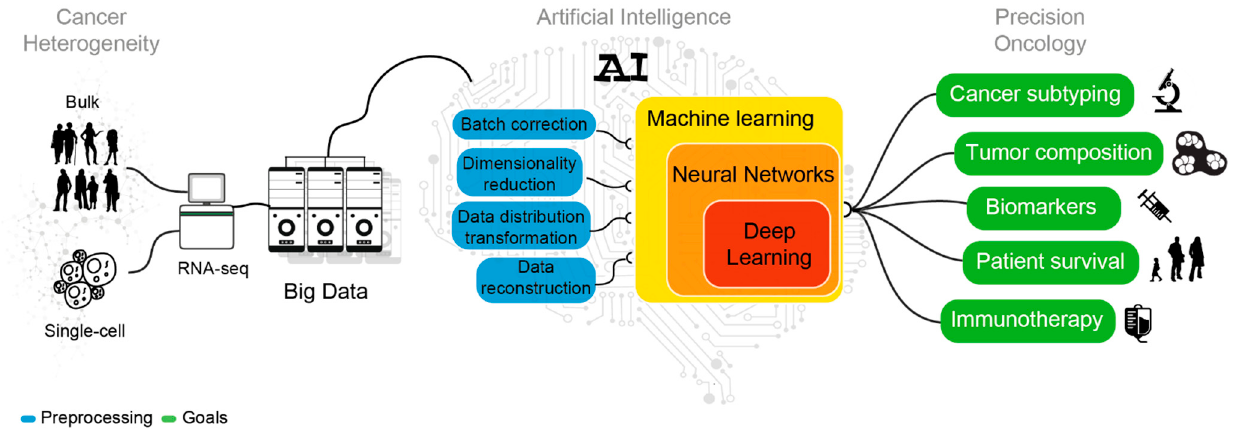
Figure 2. Sketch representing the analyses needed to decipher cancer heterogeneity and achieve an effective precision oncology.